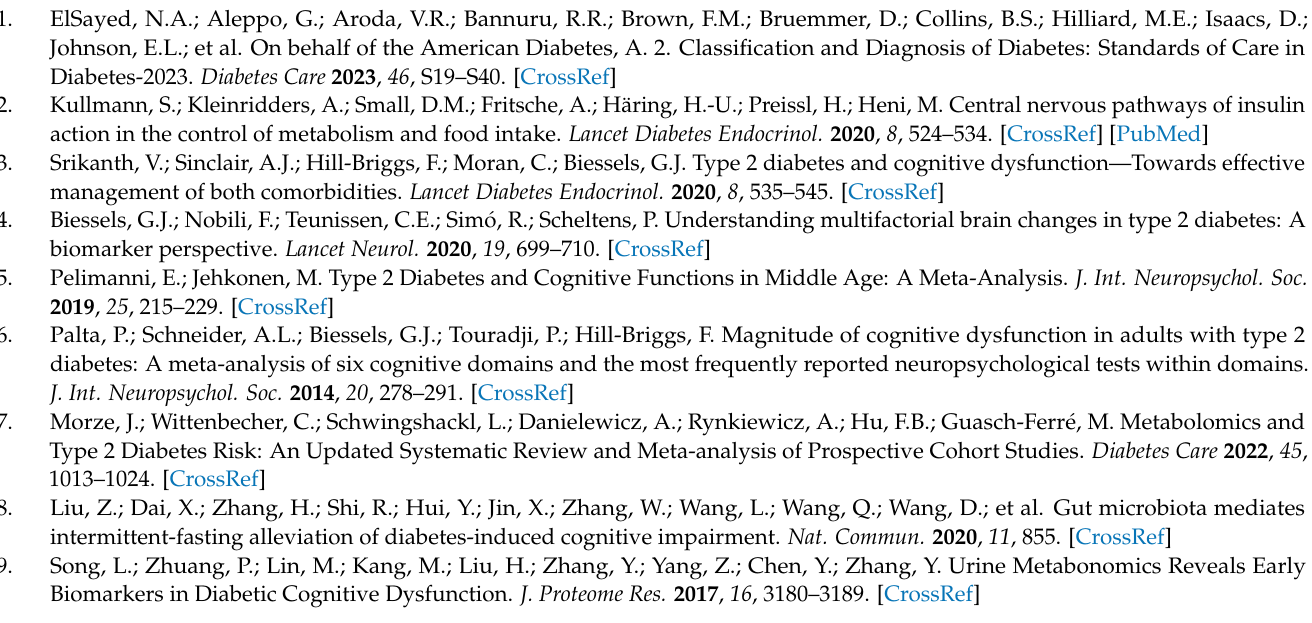
Table S1: Differential metabolites in hippocampal tissue; Table S2: Differential metabolites in